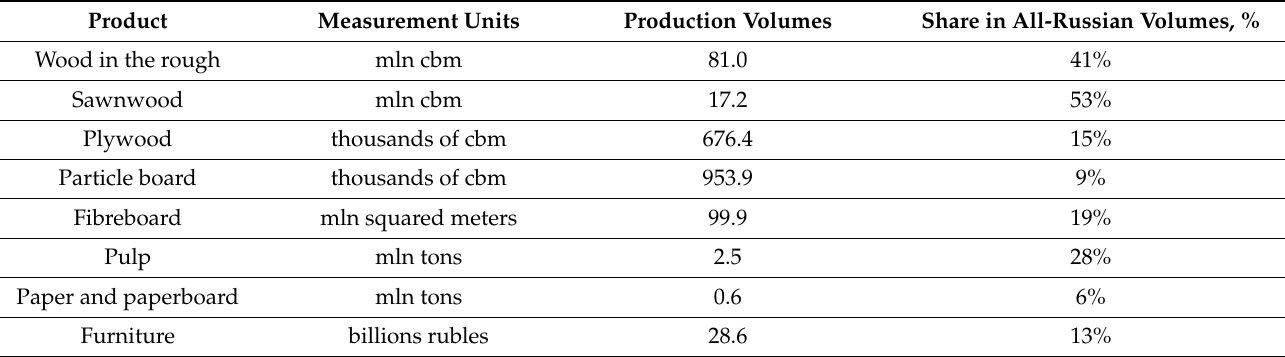
Table 3. The production volumes of wood commodities in Asian Russia,